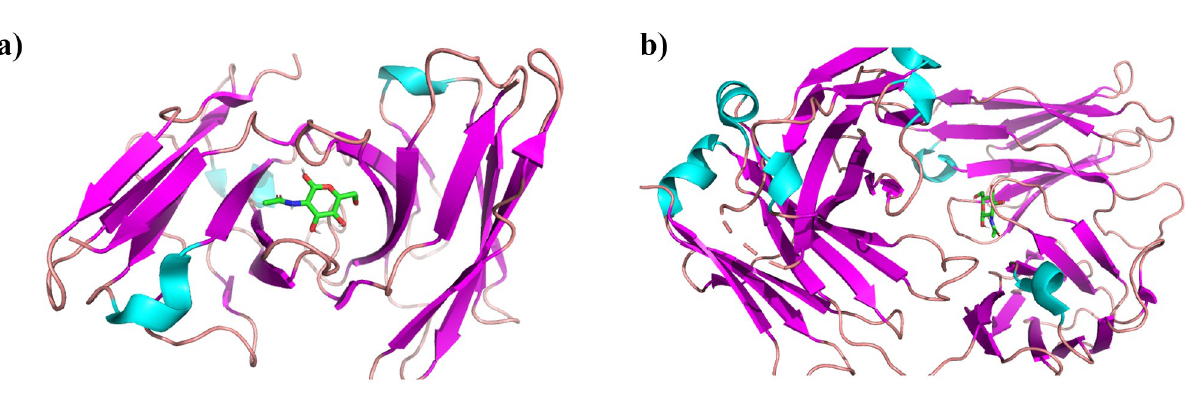
PLOS ONE | https://doi.org/10.1371/journal.pone.0252571 May 27,